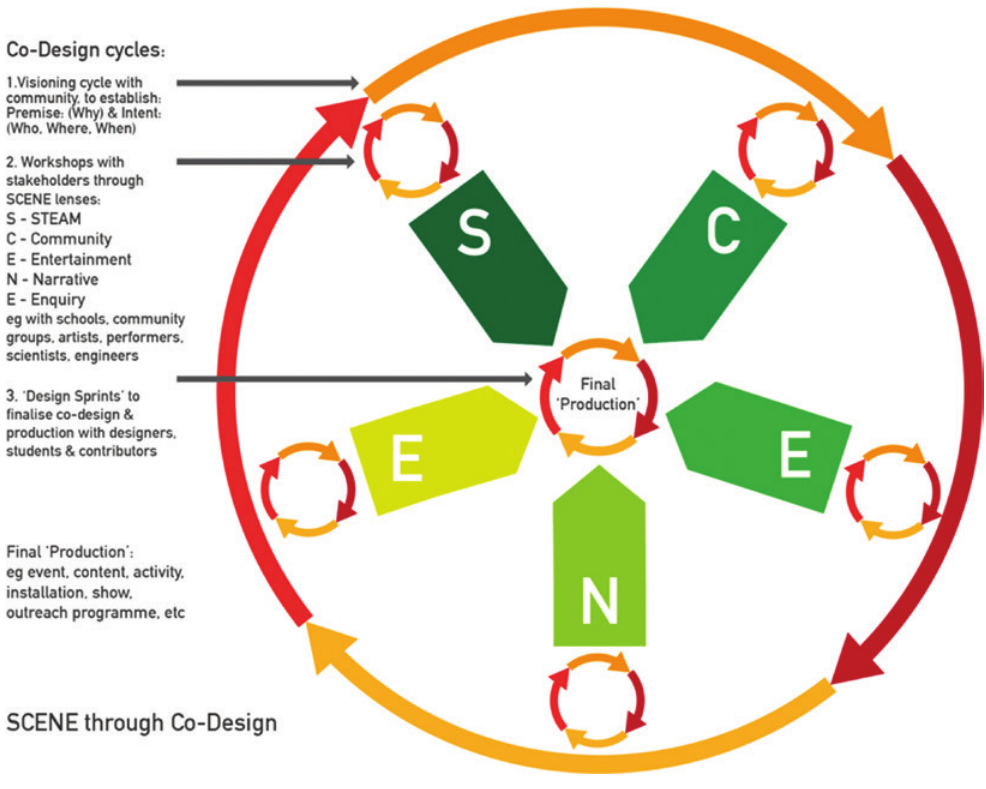
figure 3: sceNe model incorporating co-design process (credit: